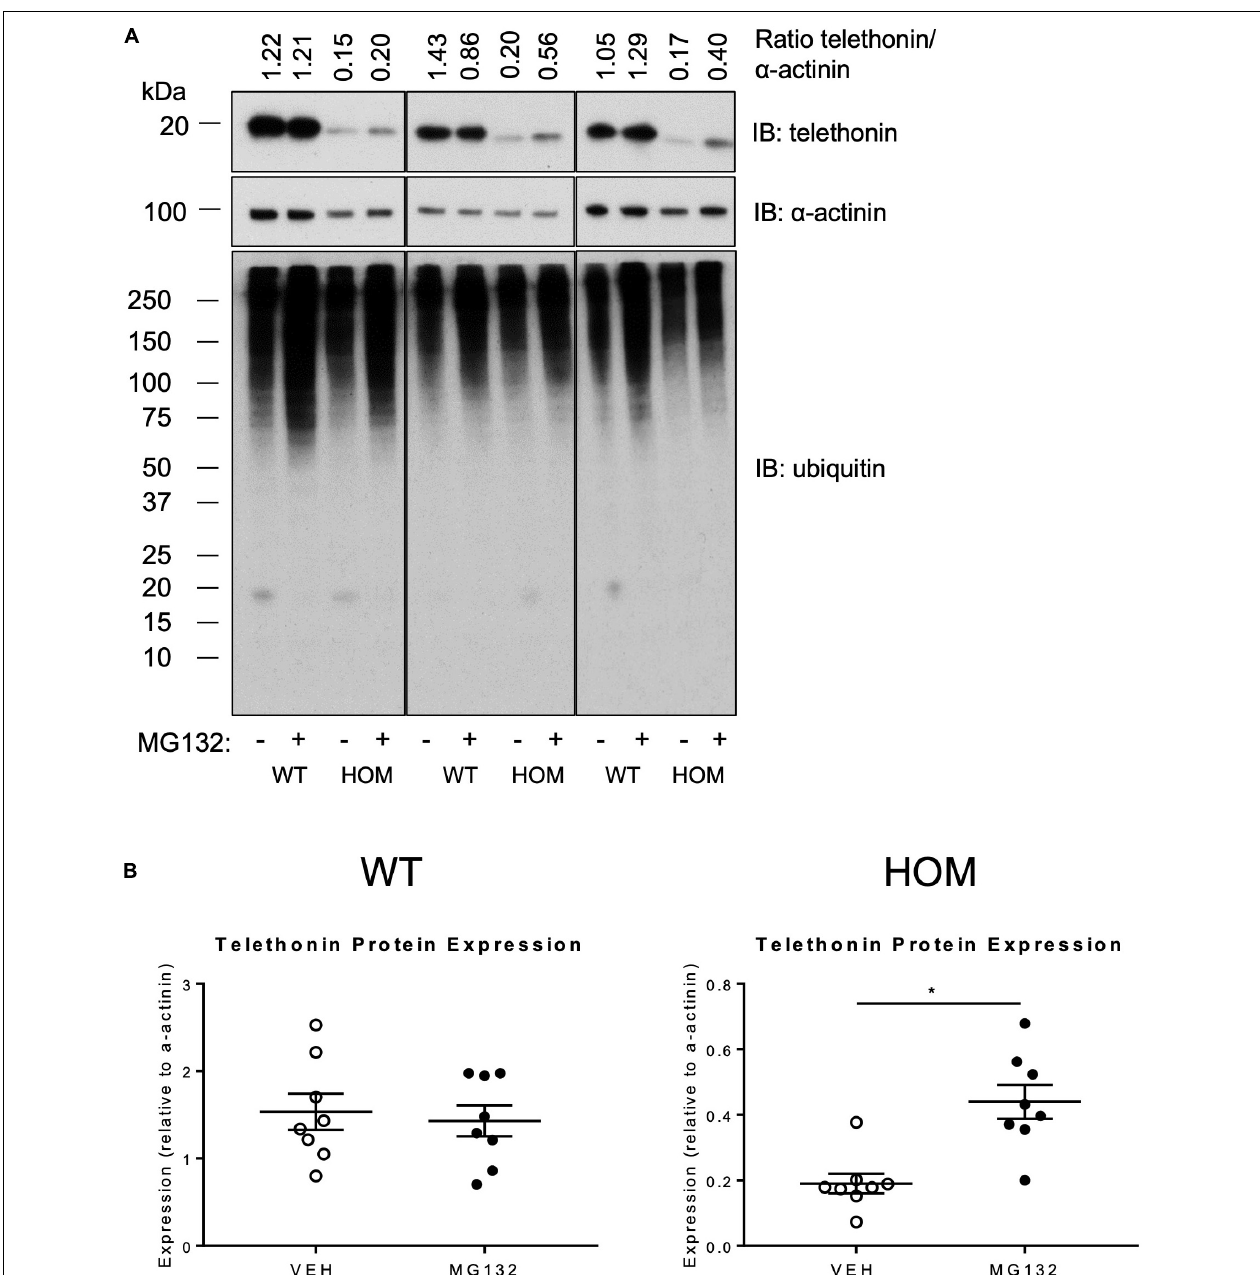
FIGURE 4 | Effect of proteasome inhibition on the expression of telethonin in Tcap S157 / 161A KI mice. (A) Immunoblot analysis of cardiomyocytes isolated from 9 to 11 week male mice treated with the vehicle DMSO (–) or 10 µ m MG132 (+); representative immunoblots from experimental replicates are presented in the columns. (B) Densitometric analysis of telethonin expression normalized to α -actinin ( n = 8). Data expressed as mean ± SEM, * p ≤ 0.05; unpaired T